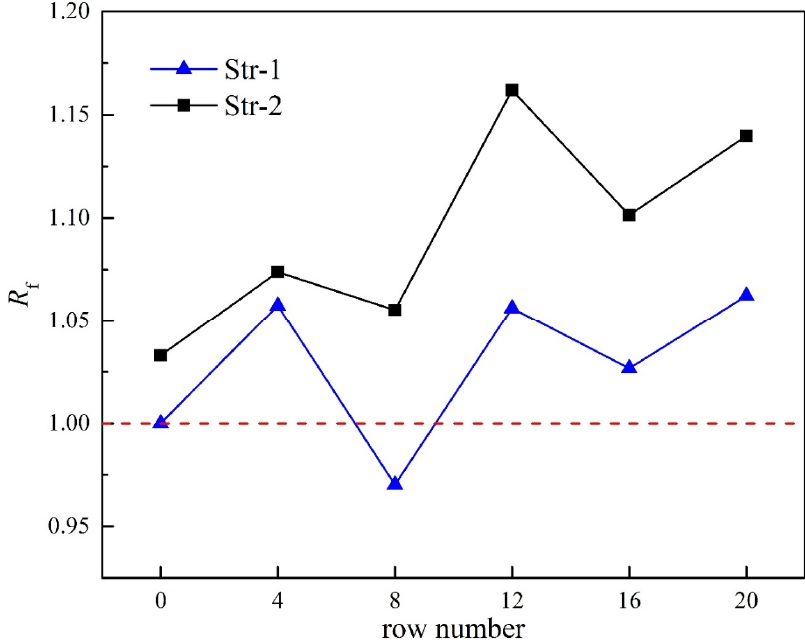
Figure 17. Cost-effectiveness of ACCs for Design, Str-1, and Str-2 cases at different wind speeds.